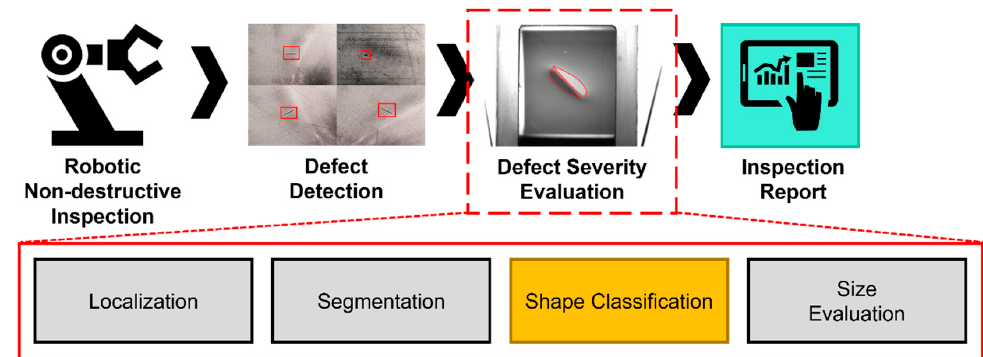
Figure 1. Future implementation of robotics-based nondestructive